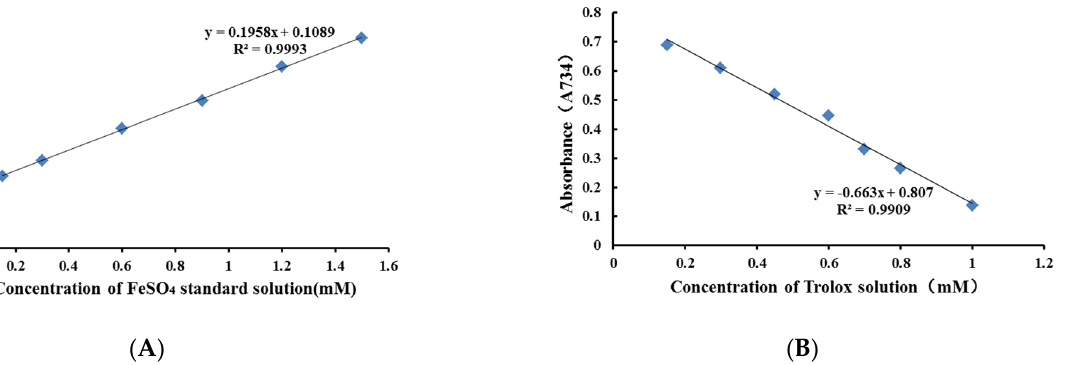
Figure 3. ( A ) Standard curve of FeSO 4 ; ( B ) standard curve of